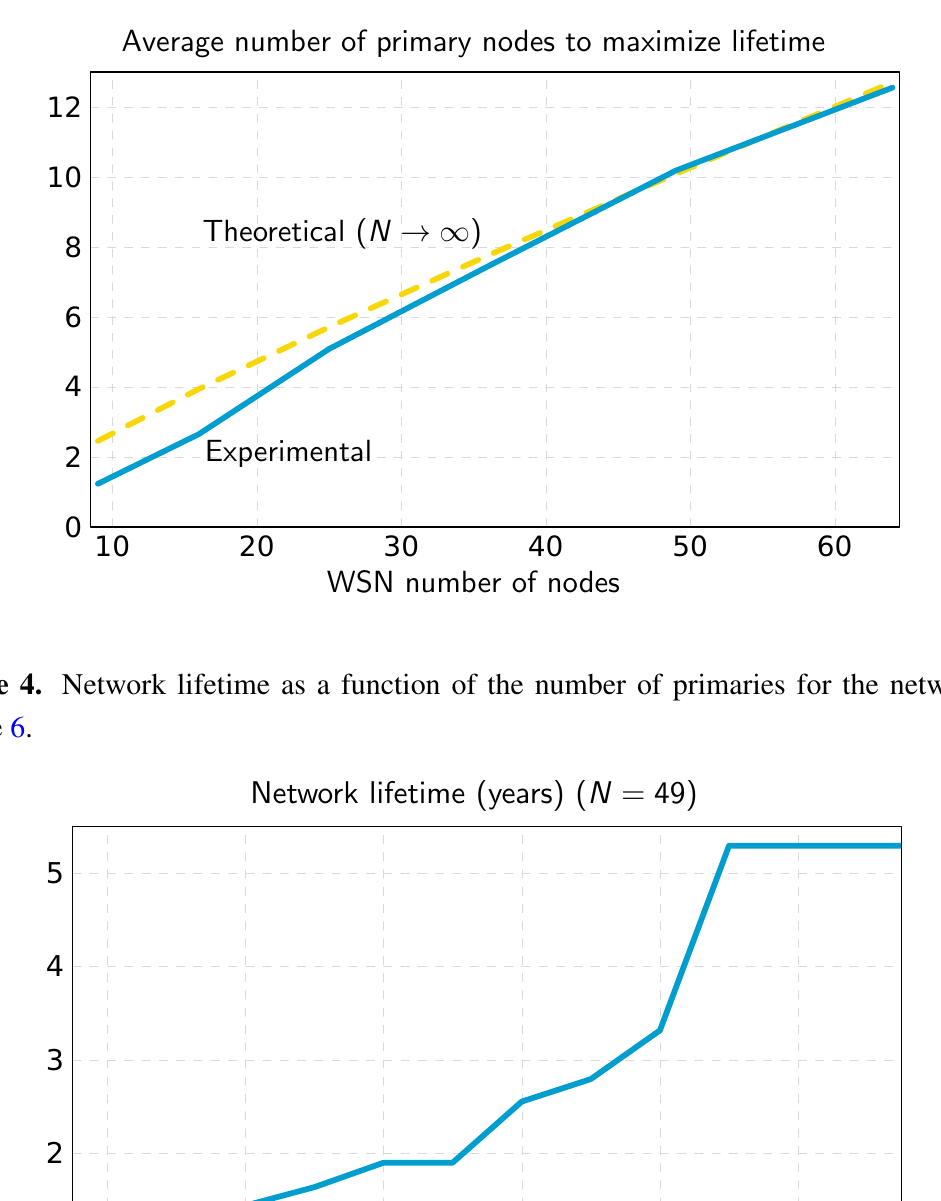
Figure 3. Comparison of theoretical and optimization results for the average minimum number of primary nodes required to maximize lifetime in a WSN.